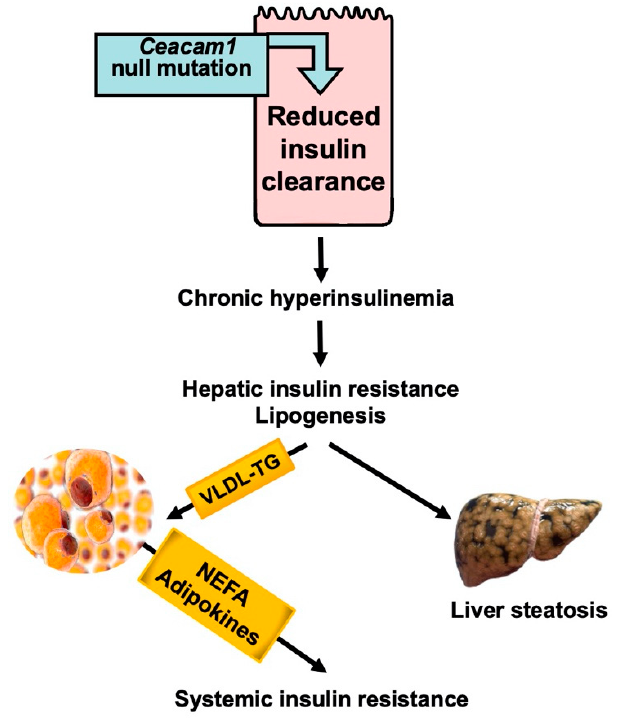
Figure 4. Reduced hepatic insulin clearance causes hepatic insulin resistance independently of NEFA release. Liver-specific Ceacam1 null mutation causes reduction in insulin clearance which, in turn, leads to chronic hyperinsulinemia. This drives hepatic insulin resistance and lipogenesis, followed by redistribution of VLDL-TG to WAT and lipolysis.